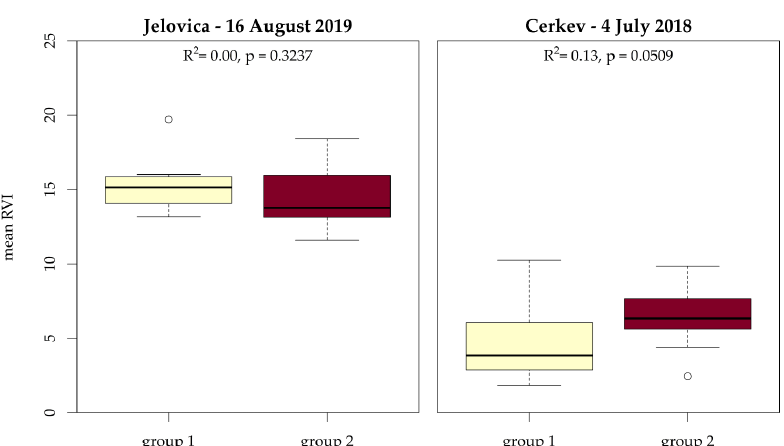
Figure 11. Difference between two groups of injuries at: Jelovica (group 1—injuries to the bark or bark and wood and resin flow; group 2—additional injuries: cracked steam, injured/exposed roots, and missing tree tops) and at Cerkev (group 1—injuries to the bark and bark and wood, resin flow, and inclusion of rocks into the injury; group 2—additional injuries: missing tree tops and branches, steam breakage, injured/exposed roots, tilted tree, and cracked stem).